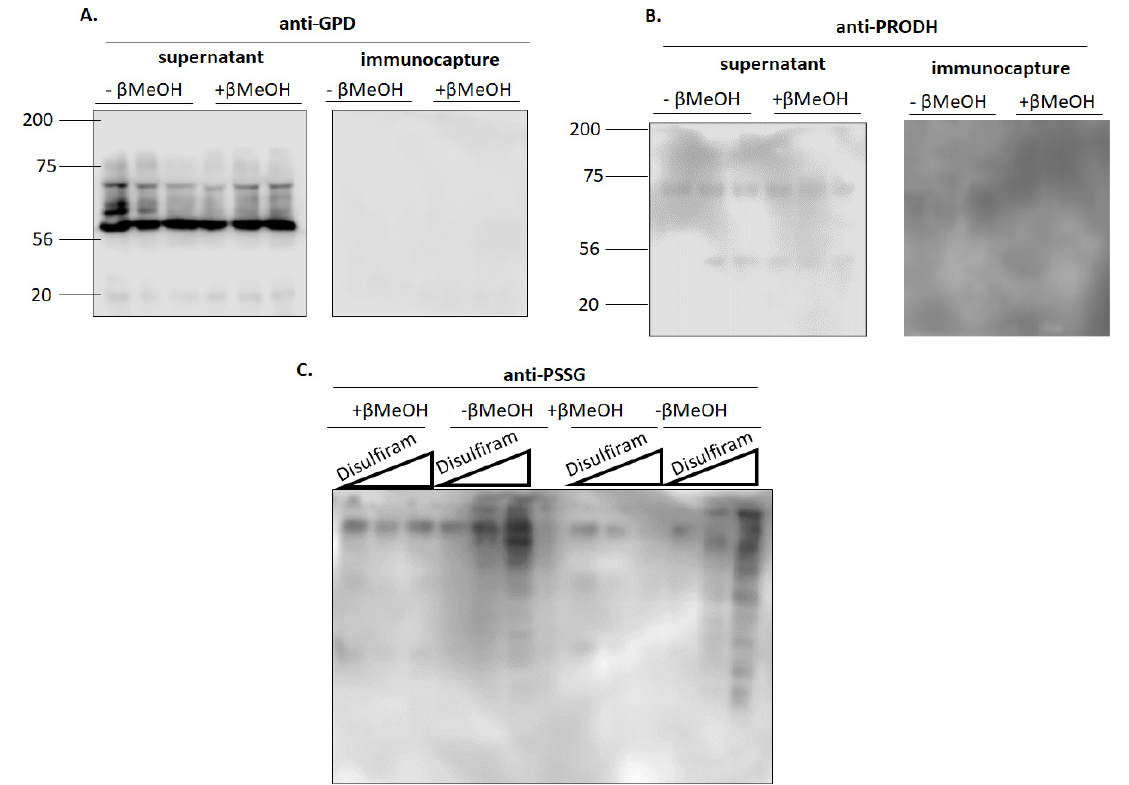
Figure 5. Induction of protein S-glutathionylation does not result in the modification of ( A ) GPD or ( B ) PRODH with glutathione. Estimation of the glutathionylation status of GPD and PRODH was conducted using disulfiram and the BioGEE switch assay. BioGEE modified proteins were isolated using magnetic streptavidin-coated beads and a magnetic rack as described in the Experimental section. The supernatant and the immunocapture fractions were collected and stored at − 80 ◦ C for Western blot analysis. Samples treated with β -mercaptoethanol served as a control to verify antibody specificity. N = 3. ( C ) Immunoblot analysis of PSSG adducts after incubation of mitochondria in disulfiram (0, 1000, 10000 nM) and BioGEE (1 mM). Samples also included β